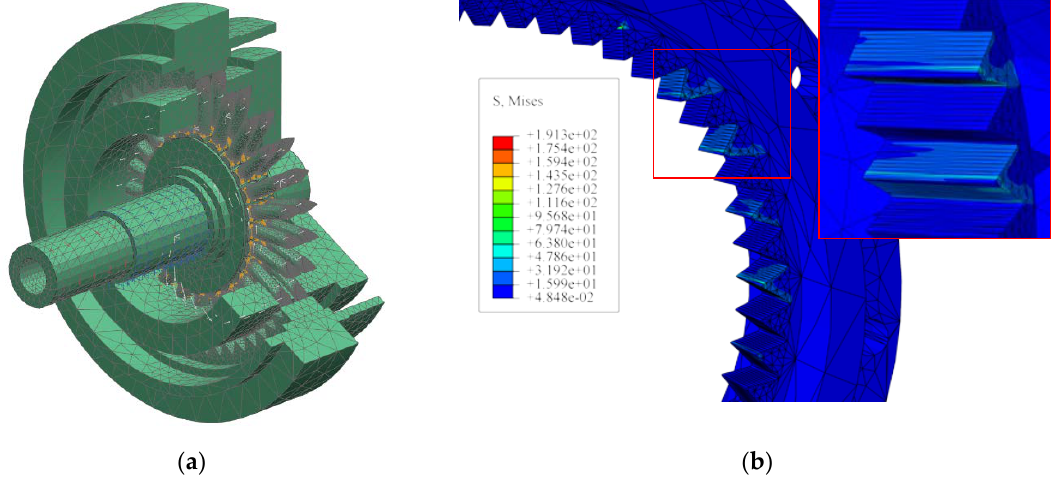
Figure 15. FEM simulation of the prototype with the two − lobe wave generator. ( a ) Grid partition; ( b ) Contact stresses of the teeth and ring gear.